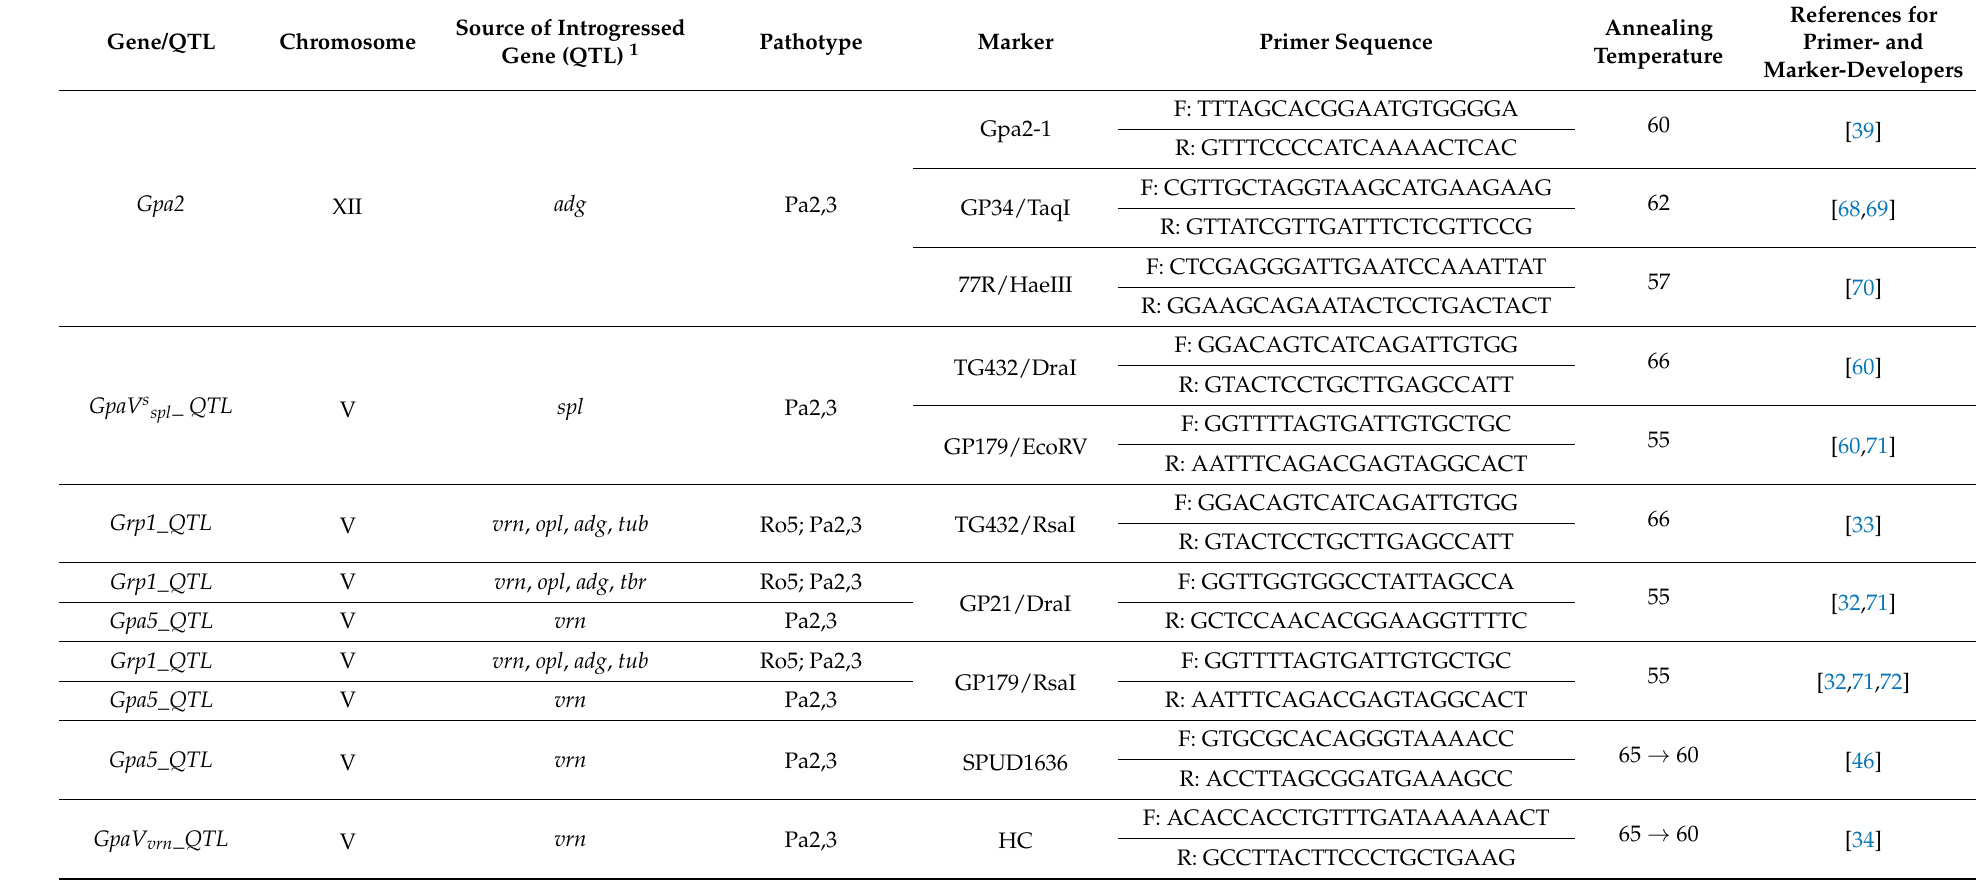
Table 3. DNA markers associated with genes (QTLs) conferring PCN resistance used in this